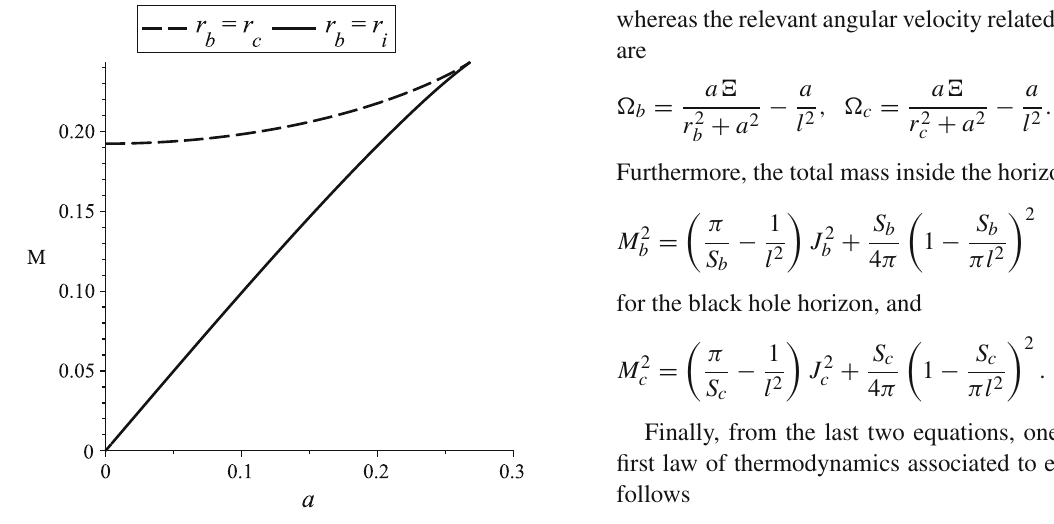
Fig. 1 Plots for r c = r h and r i = r h in the case of l = 1. The solid line represents the extremal state of black hole, whereas the dashed